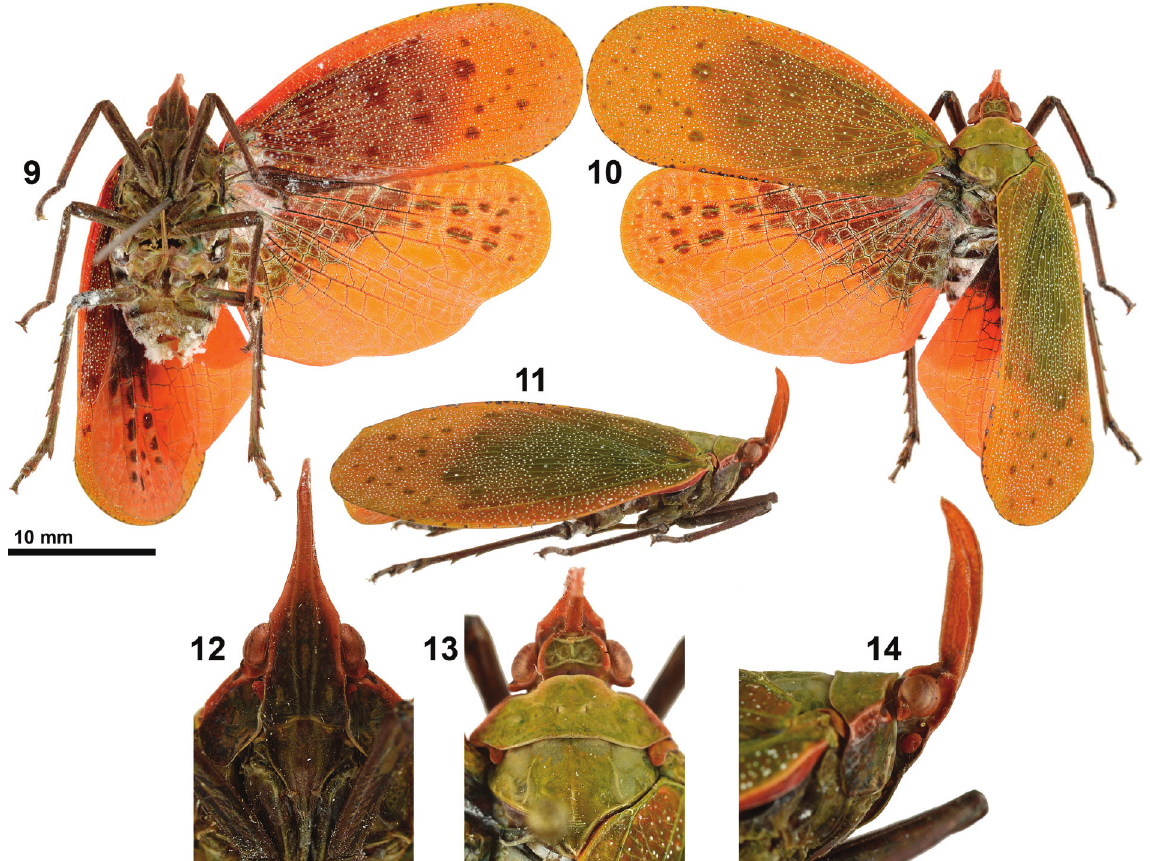
Figs 9–14. Egregia brevirostris (Lallemand, 1959), ♂, from Tawau (TL: 30.2 mm). 9 . Habitus: ventral view. 10 . Habitus, dorsal view. 11 . Habitus: right lateral view. 12 . Head: normal view of frons. 13 . Head and thorax: dorsal view. 14 . Head and thorax: right lateral view (Figs 12-14 not to